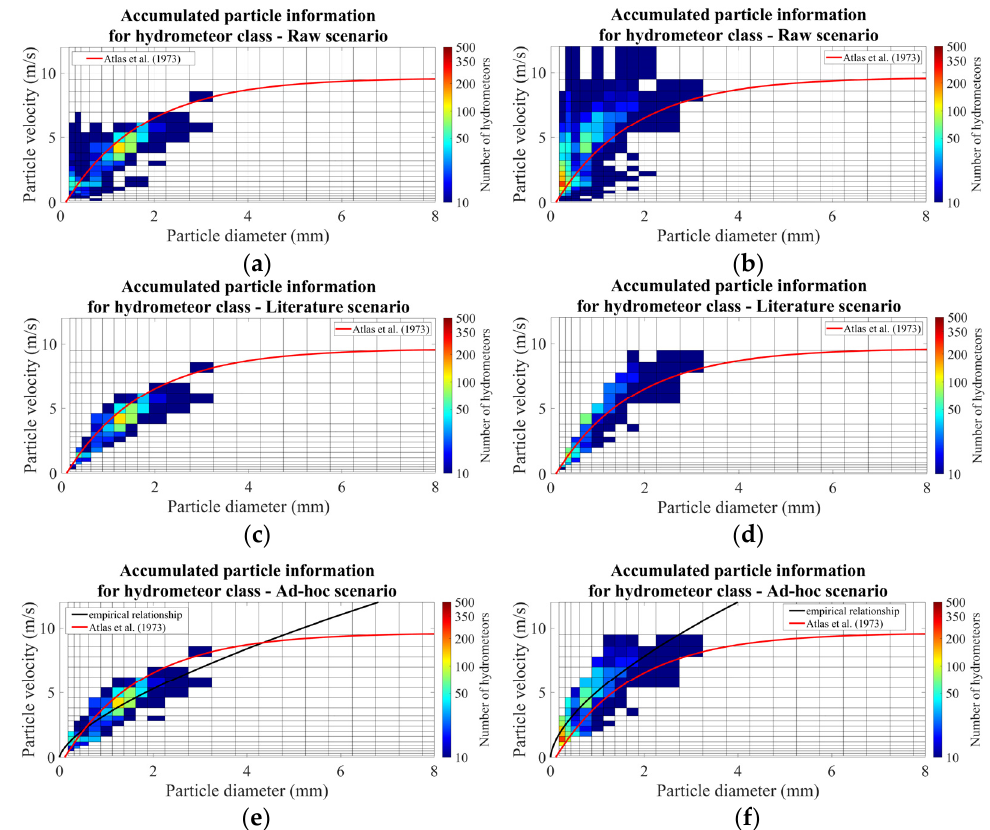
Figure 3. Example of a spectrograph measured by disdrometer under light (left panels) and moderate (right panels) wind conditions. More specifically, panels ( a , b ) show raw data; panels ( c , d ) show the spectra obtained after applying the literature method, and panels ( e , f ) show the data filtered through the ad hoc method. The color scale indicates the number of drops in each size-velocity class. The empirical relationship between raindrop diameter and fall velocity for literature and ad hoc filtering procedures is highlighted as the red and black curve, respectively.